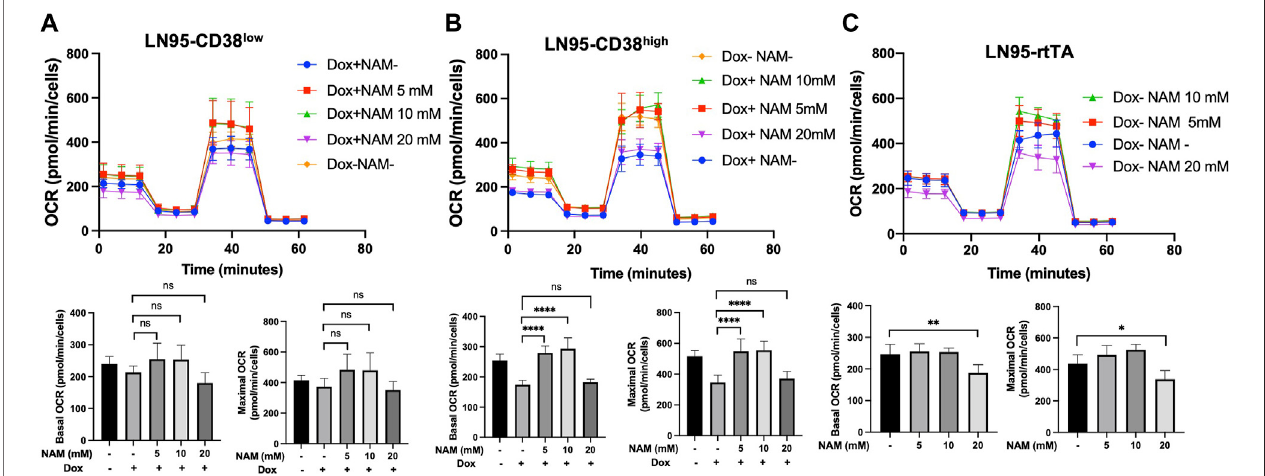
FIGURE 5 | Restoration of mitochondrial respiration by 10 mM NAM. (A,B,C) OCR of LN95-CD38 low (A) , LN95-CD38 high (B) and LN95-rtTA (C) measured by mitochondrialstresstest.BasalOCR(measurementpoint1)andmaximalOCR(measurementpoint8)werecompared.Mean±SDvaluesfrom fi vereplicatesareshown. p values for Turkey ’ s multiple comparison tests are indicated in each fi gure. ns: not signi fi cant, *: p < 0.05, **: p < 0.01,****: p <